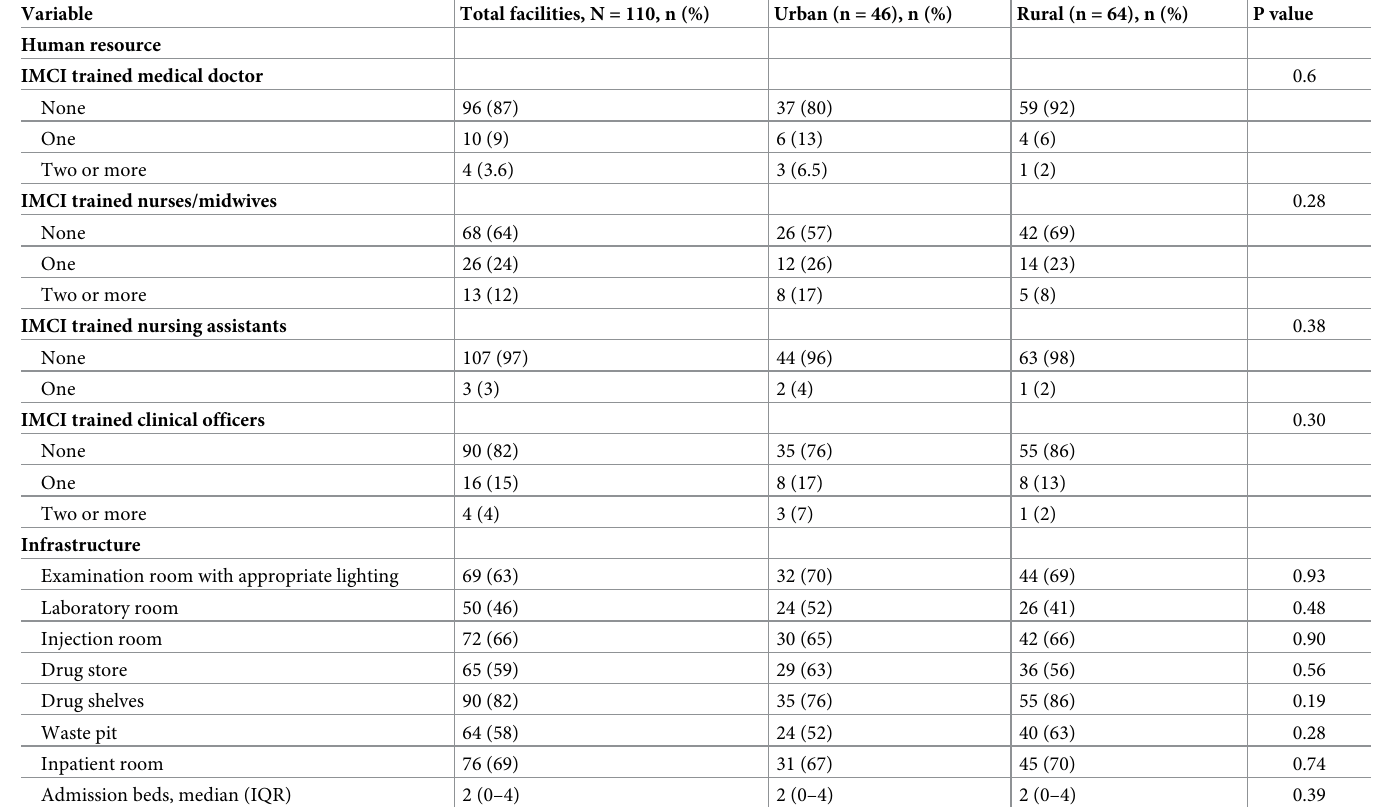
Table 5. Availability of health workers trained in IMCI, and, infrastructure in LLPHFs in Mbarara district, Uganda by location status of the